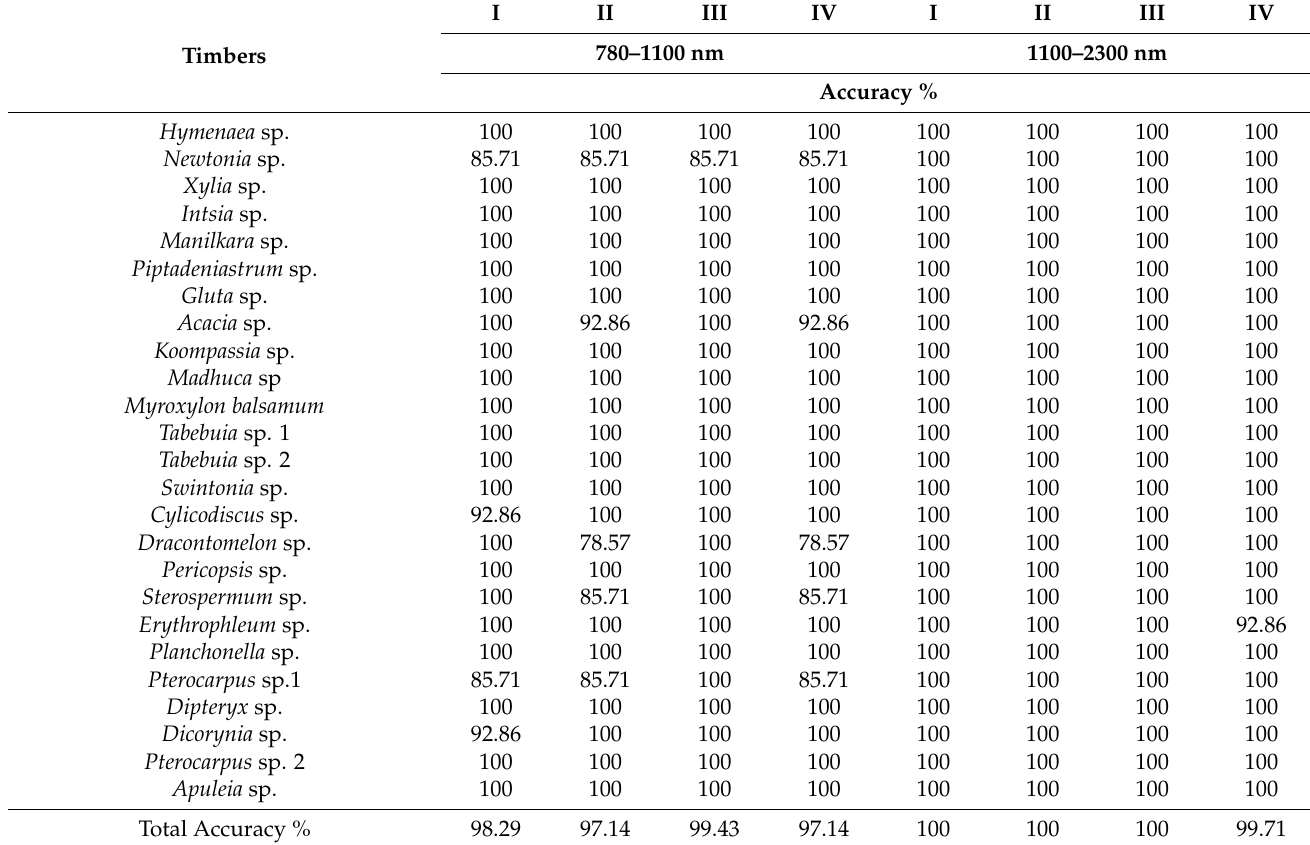
Table 5. Identification accuracy of the SVM model based on two short NIR bands combined with GLCM